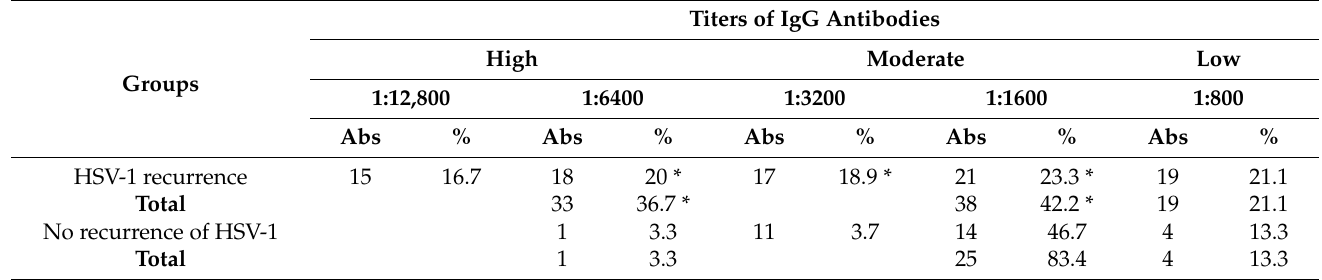
Table 1. Frequency of distribution (%) of IgG antibodies to HSV-1 among pregnant women in the first trimester of